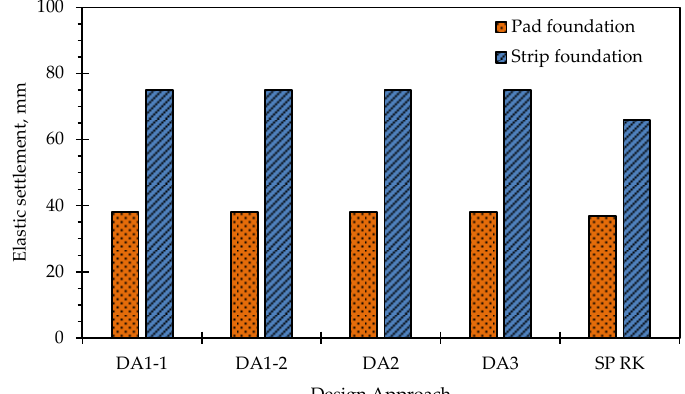
Figure 6. Comparison of the values of elastic settlement for pad and strip foundations adhering to Kazakhstani and European approaches.